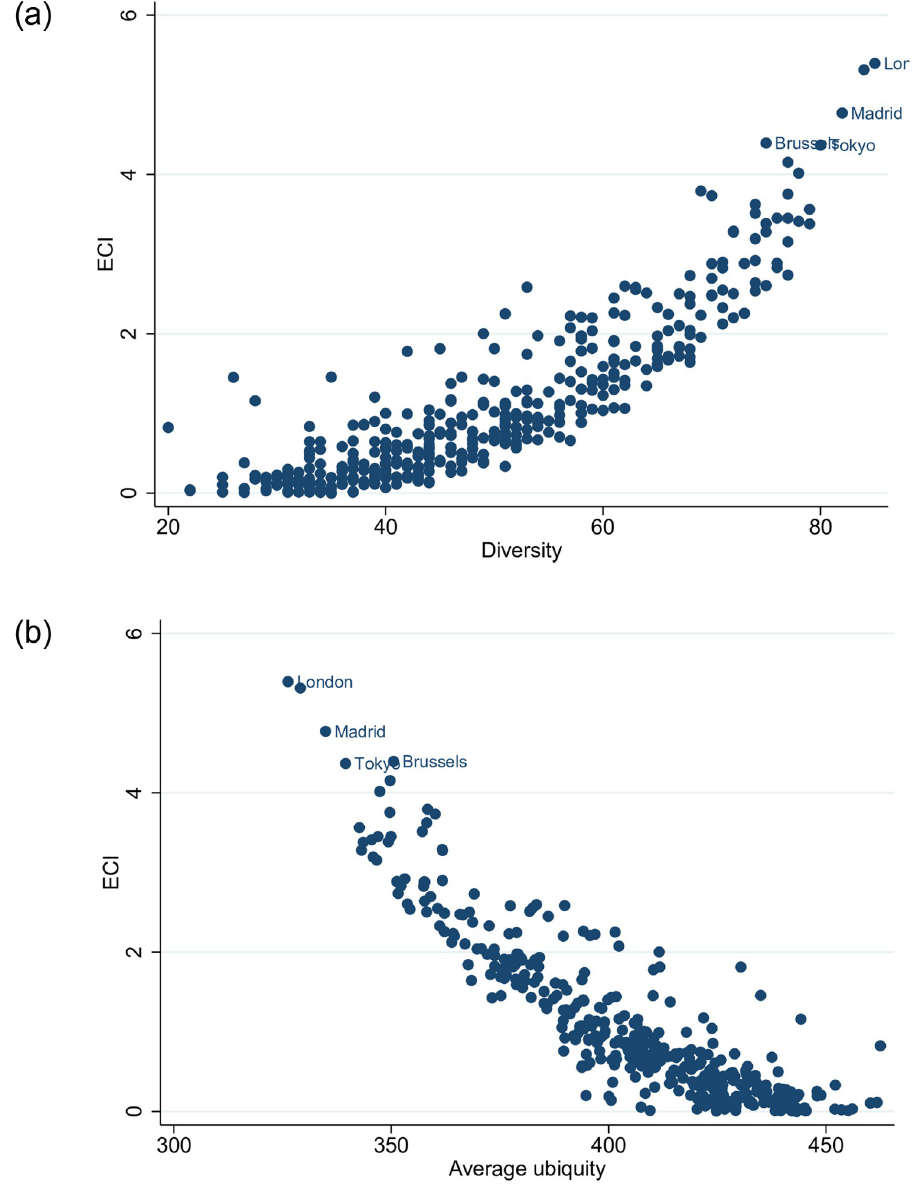
Fig 2. Cities’ economic complexity (ECI), diversity and average ubiquity. [a] ECI vs Diversity; [b] ECI vs Average ubiquity. The figures have been generated using StataSE 14.